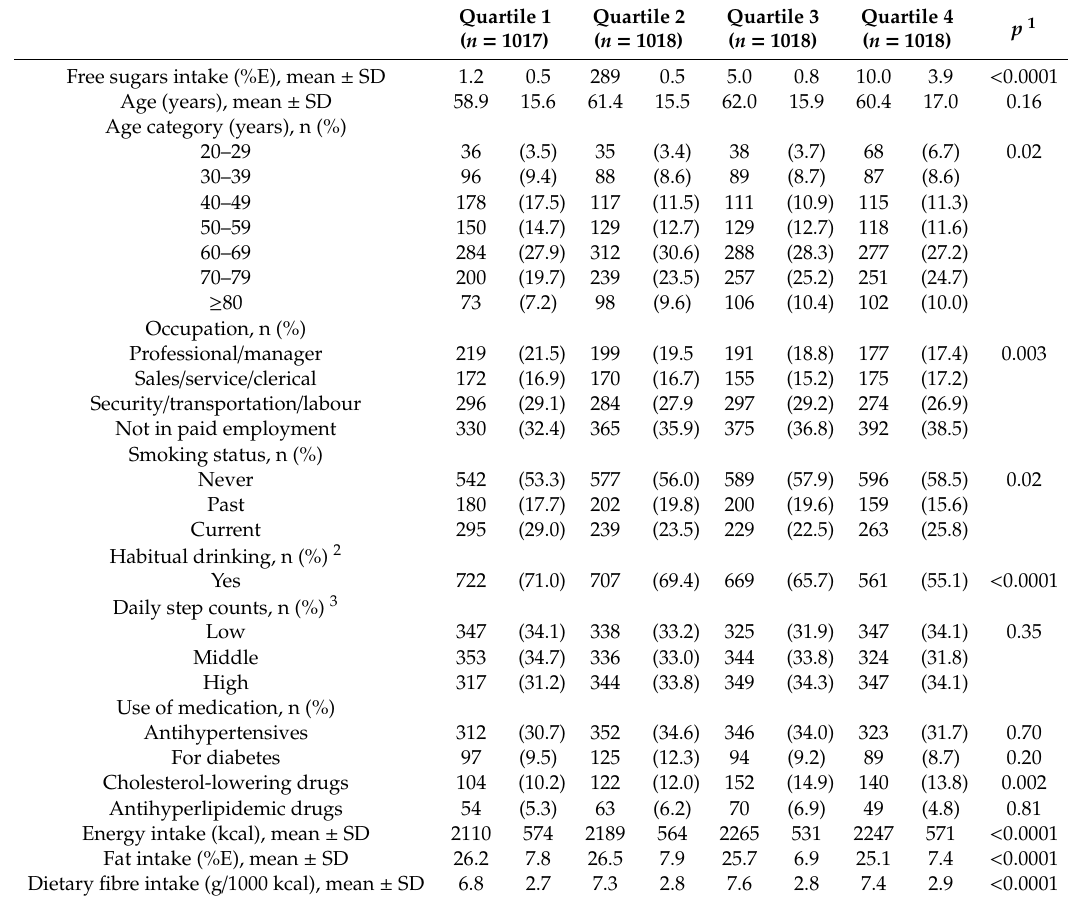
Table 2. Basic characteristics of Japanese men ( n = 4701) according to free sugars intake: the 2016 National Health and Nutrition Survey, Japan.